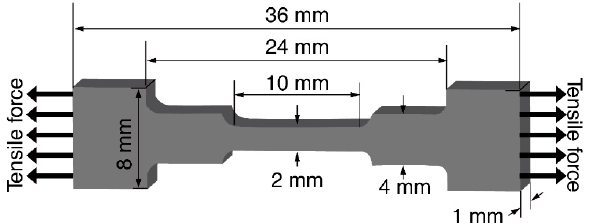
Figure 1. Schematic illustration of the tensile test specimen.